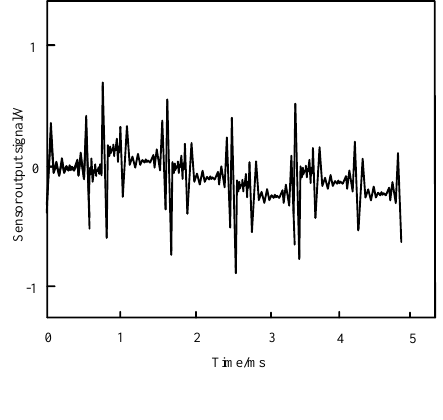
Figure 8. Life cycle of wireless sensor network